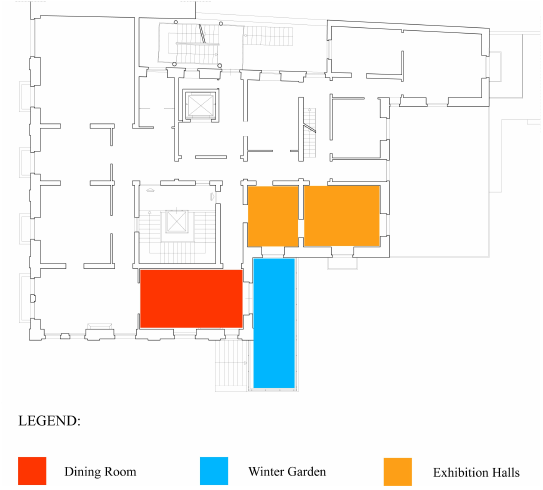
Figure 7. Location of environments analysed by